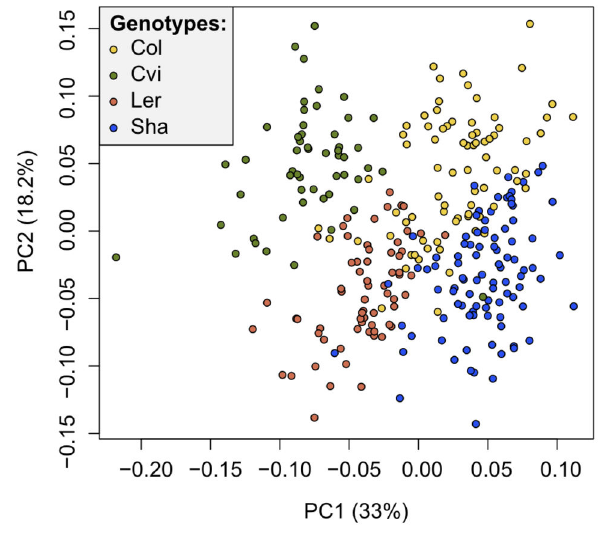
Figure 3. Principal component analysis of data from the heat experiment. Colors denote different genotypes, indicating their distinct phenotypes.